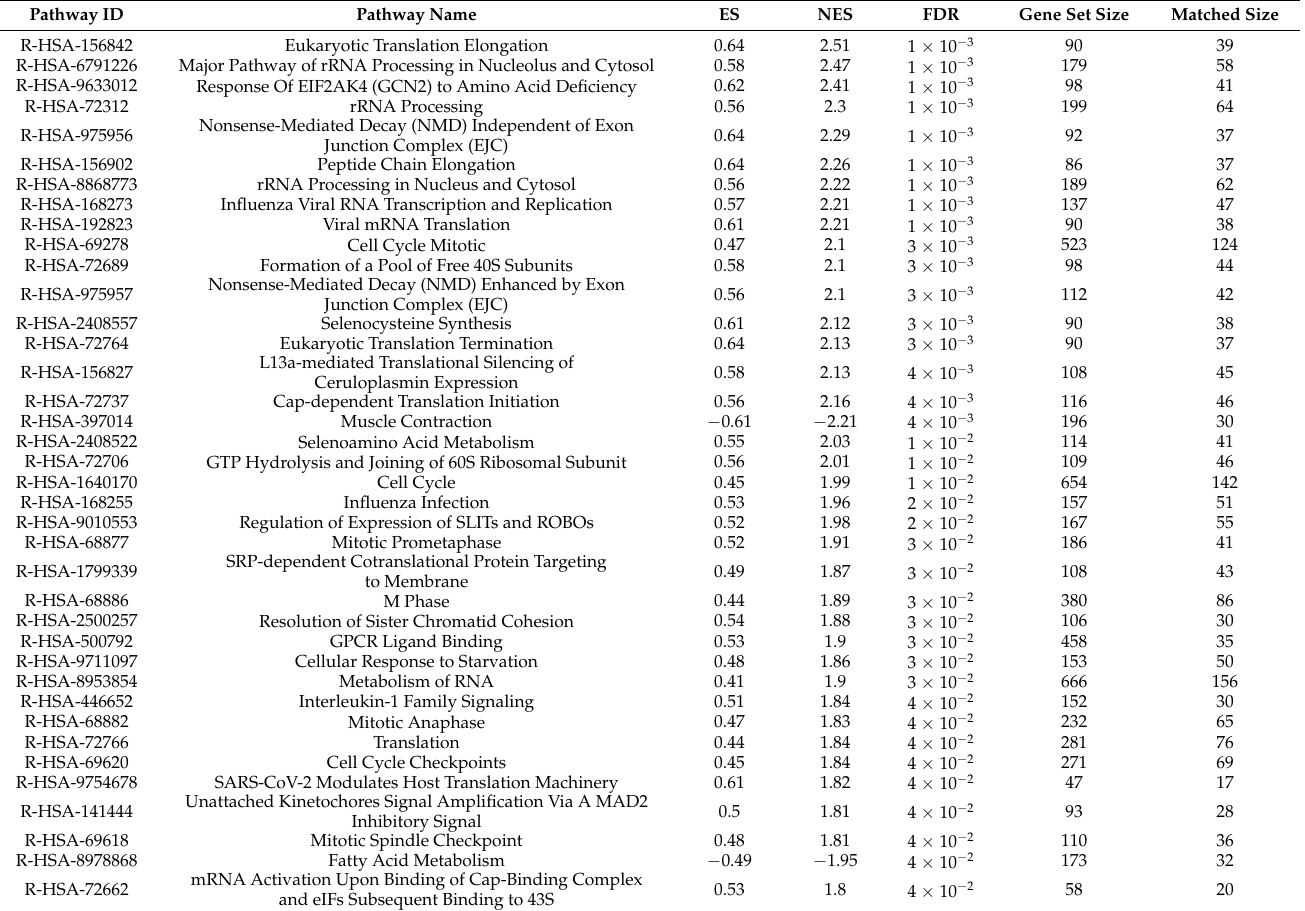
Table 1. Enriched biological pathways, according to the Reactome 2022 database, associated with lymphatic dissemination in LAPC in a sample of Russian patients.